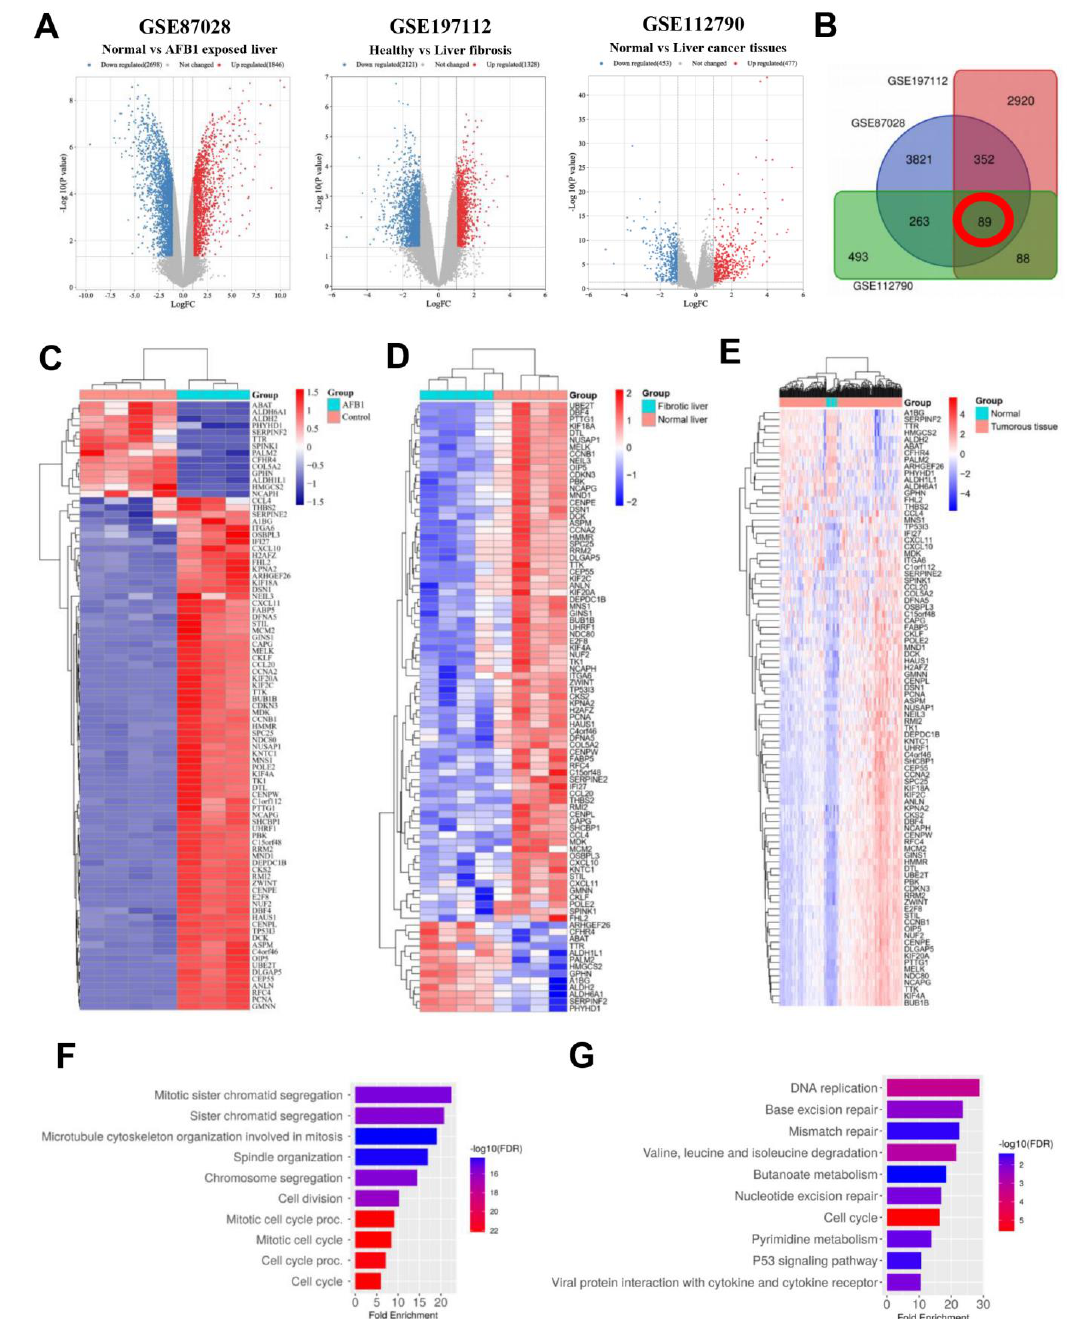
Figure 1. Differentially expressed genes (DEGs) and functional enrichment analysis in AFB1-exposed, liver fibrosis and liver cancer datasets. ( A ) Volcano plot of DEGs in GSE87028, GSE197112 and GSE112790 datasets. Red color indicated up-regulated genes and blue color indicated down-regulated genes. ( B ) Venn diagram of overlapping DEGs among three GEO datasets. ( C – E ) Heat maps of overlapping DEGs in GSE87028, GSE197112 and GSE112790 datasets. ( F ) Gene ontology (GO) biological processes (BP) enrichment analysis of 89 overlapping DEGs. ( G ) Kyoto encyclopedia of genes and genomes (KEGG) pathway analysis of 89 overlapping DEGs.